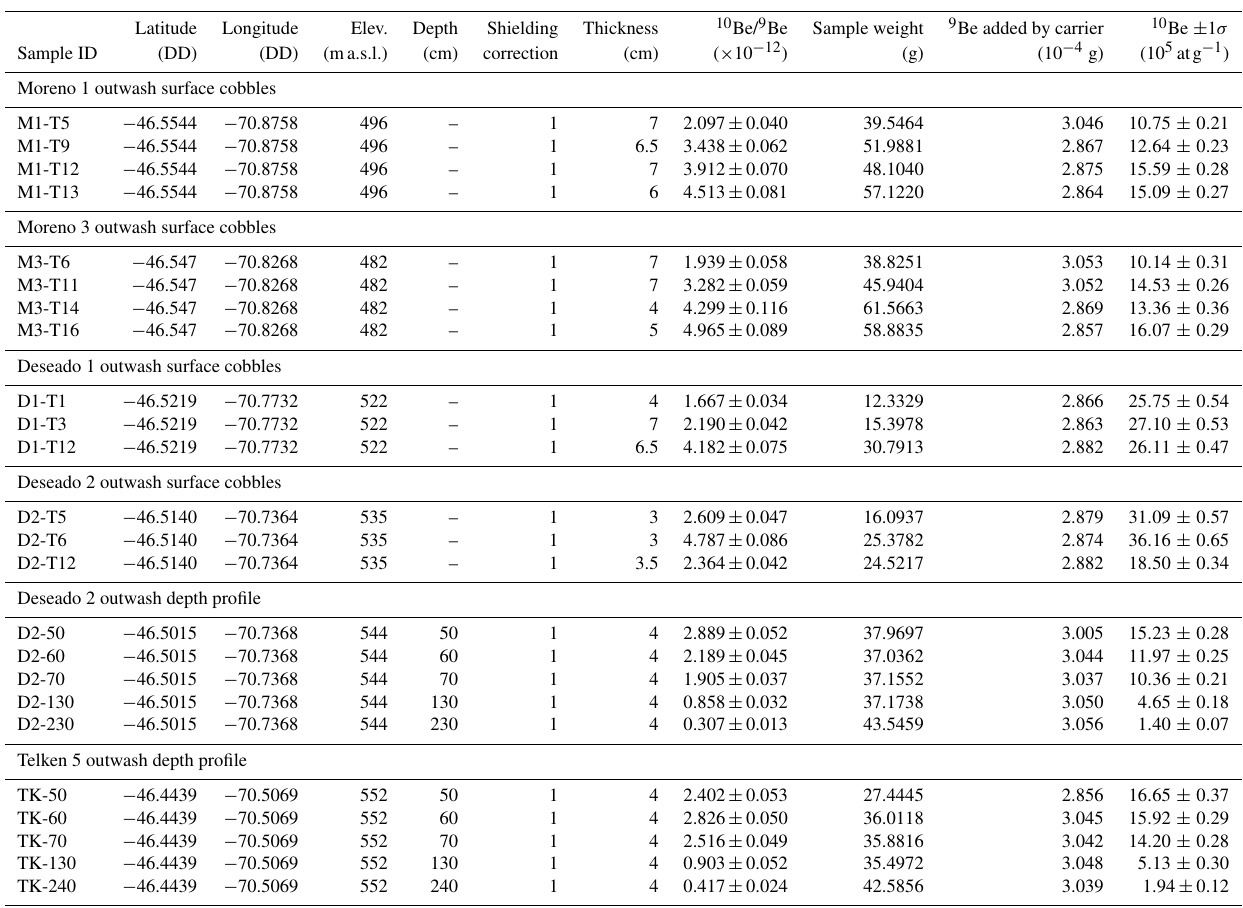
Table 1. Cosmogenic 10 Be nuclide data for outwash surface cobbles and depth profile samples. Moreno 1 and 3 data are already published in Hein et al.